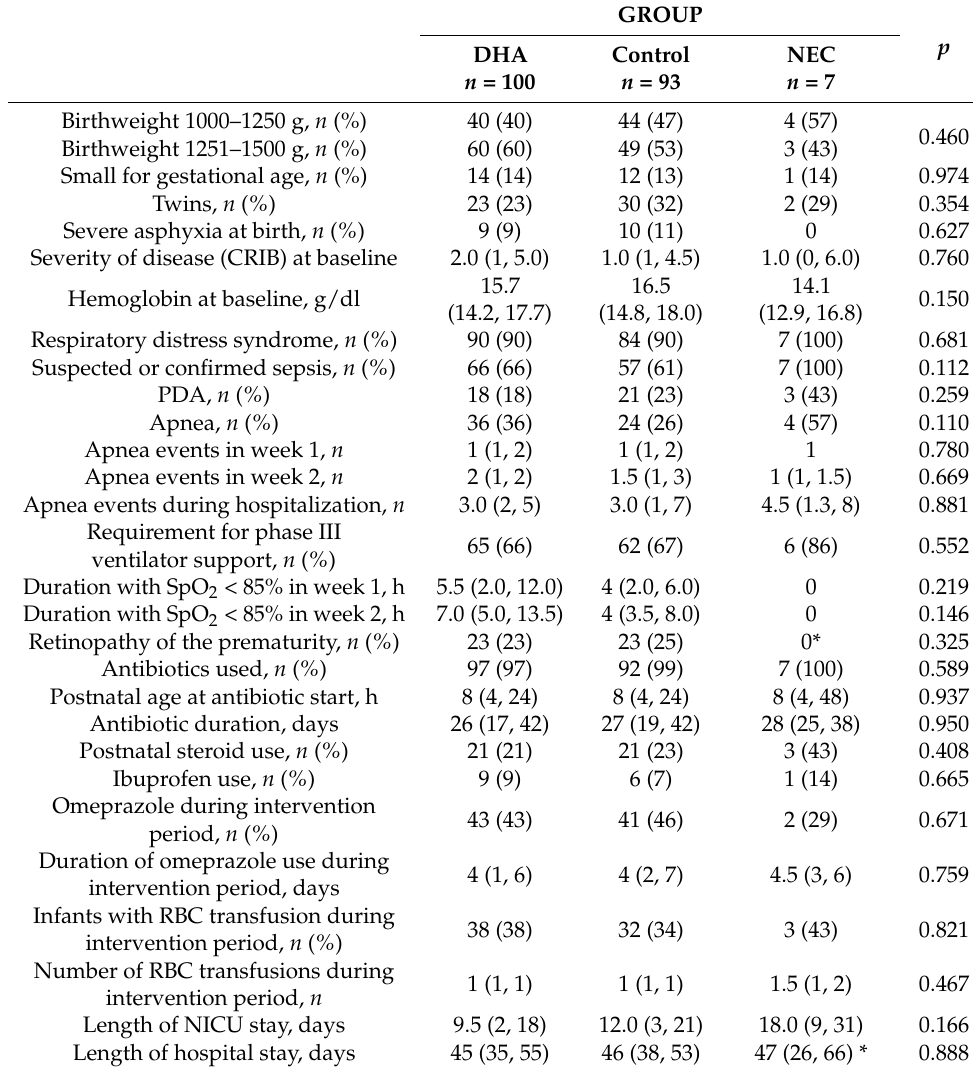
Table 3. Clinical course and medical management during the hospital stay of the very low birth weight infants stratified by confirmed necrotizing enterocolitis